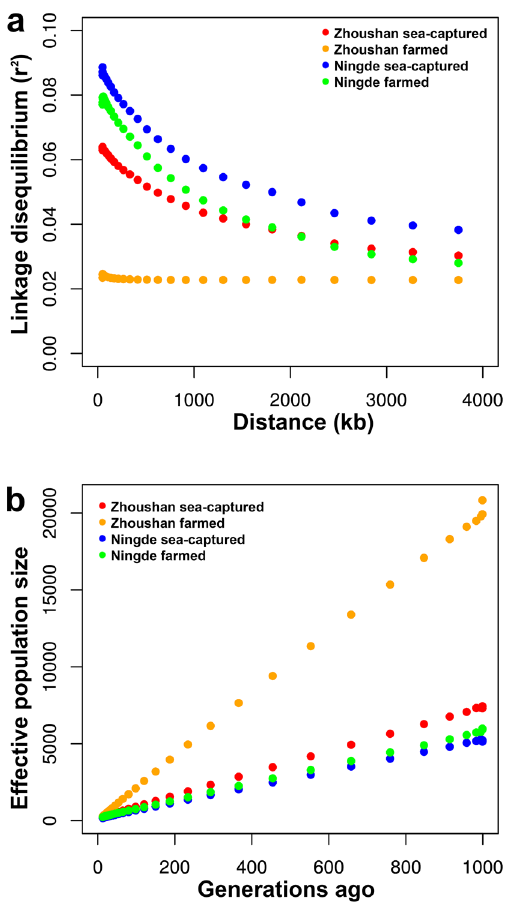
Figure 3. Trends of effective population sizes. ( a ) LD decay (r 2 ) from 0 to 4000 kb for four populations. The x-axis represents marker distances between pairwise SNPs. The y-axis represents r 2 values of linkage disequilibrium. ( b ) Effective population sizes of four populations over the past 1000 generations. All of the four populations showed decreasing trends.